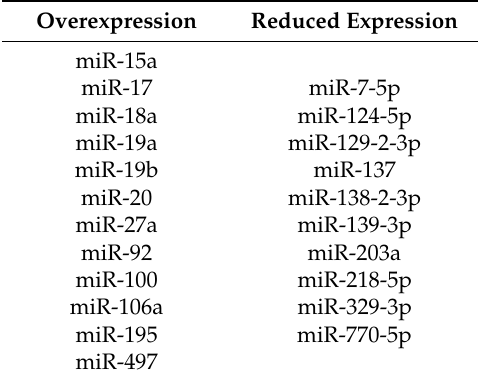
Expression of particular miRNA molecules detected in pediatric high-grade glioma (HGG) population. Overexpression